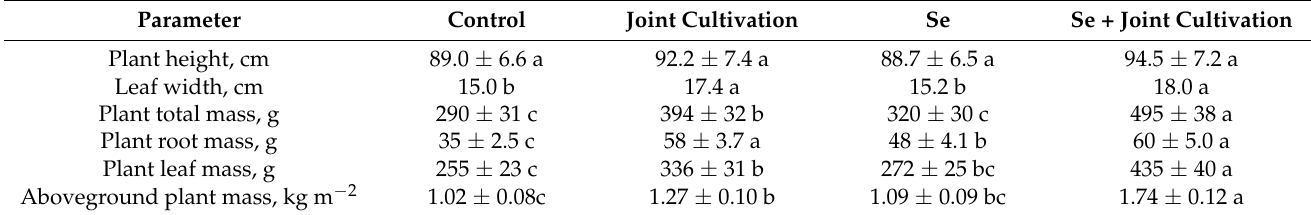
Table 2. Morphological characteristics and yield of horseradish ( Armoracia rusticana ).